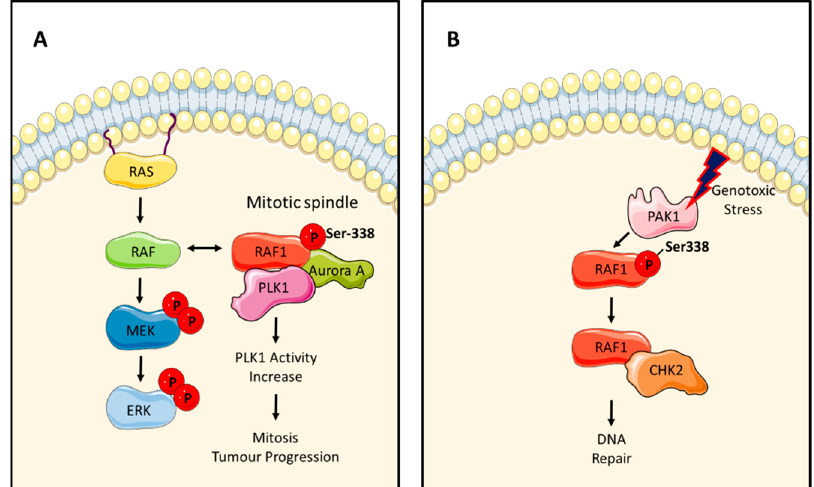
Figure 7. RAF1 kinase-independent regulation of cell cycle and mitosis check points. ( A ) RAF1 binds to PLK1 and Aurora A in the mitotic spindle and activates these kinases. ( B ) PAK1 promotes the interaction of RAF1 with CHK2 upon genotoxic effect, promotes DNA repair and prevents the activation of the DNA damage apoptotic pathway.